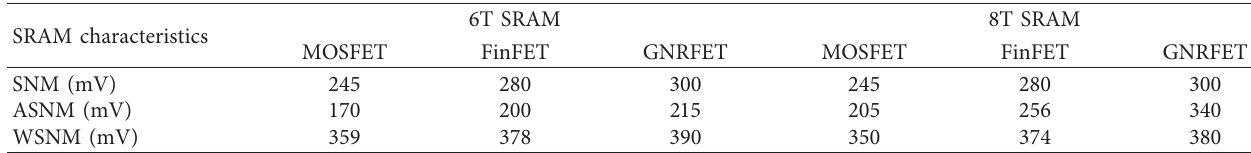
Table 4: Analysis of noise margin of MOSFET-, FinFET-, and GNRFET-based technology.